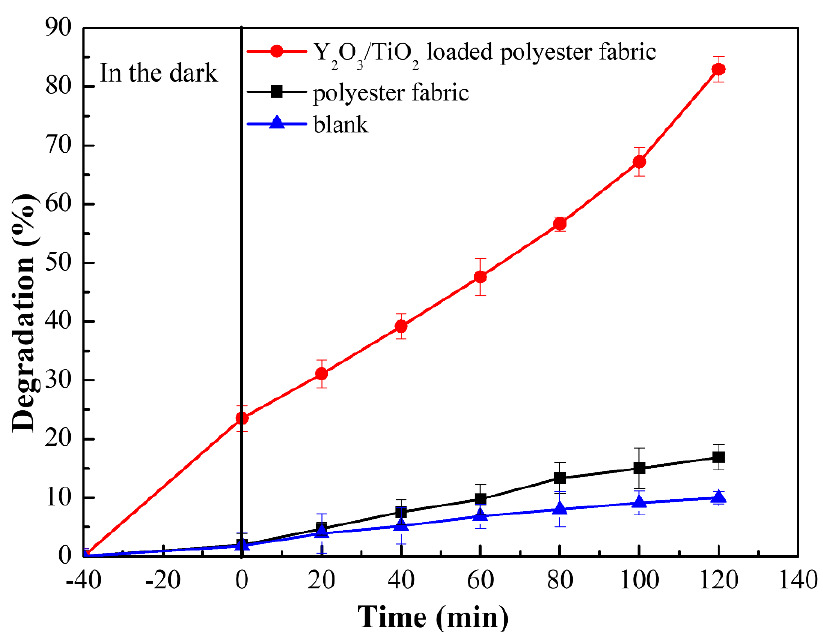
Figure 11. Degradation of methyl orange under xenon lamp irradiation.